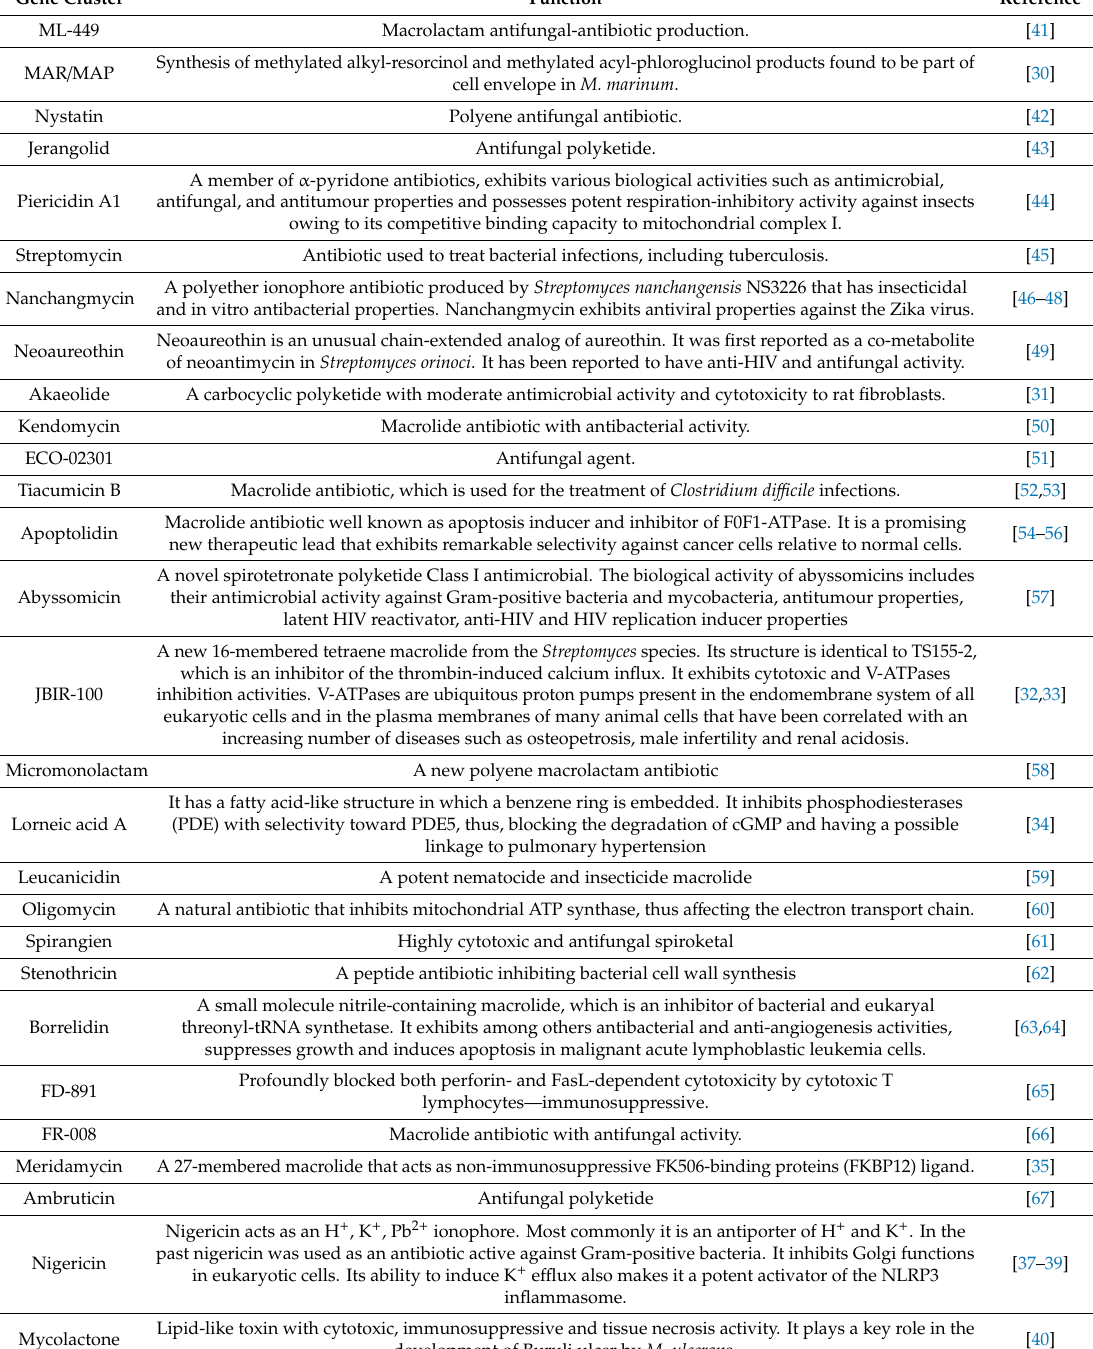
Table 2. Functional analysis of homolog CYP139A P450 gene